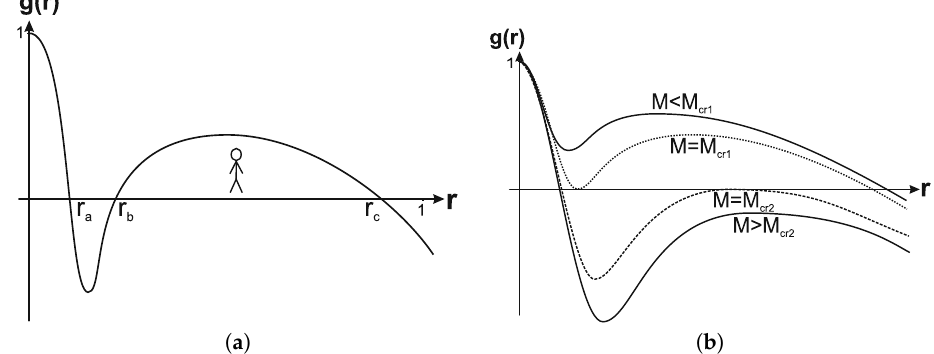
Figure 1. Typical behavior of the metric function g ( r ) for the case of two vacuum scales.